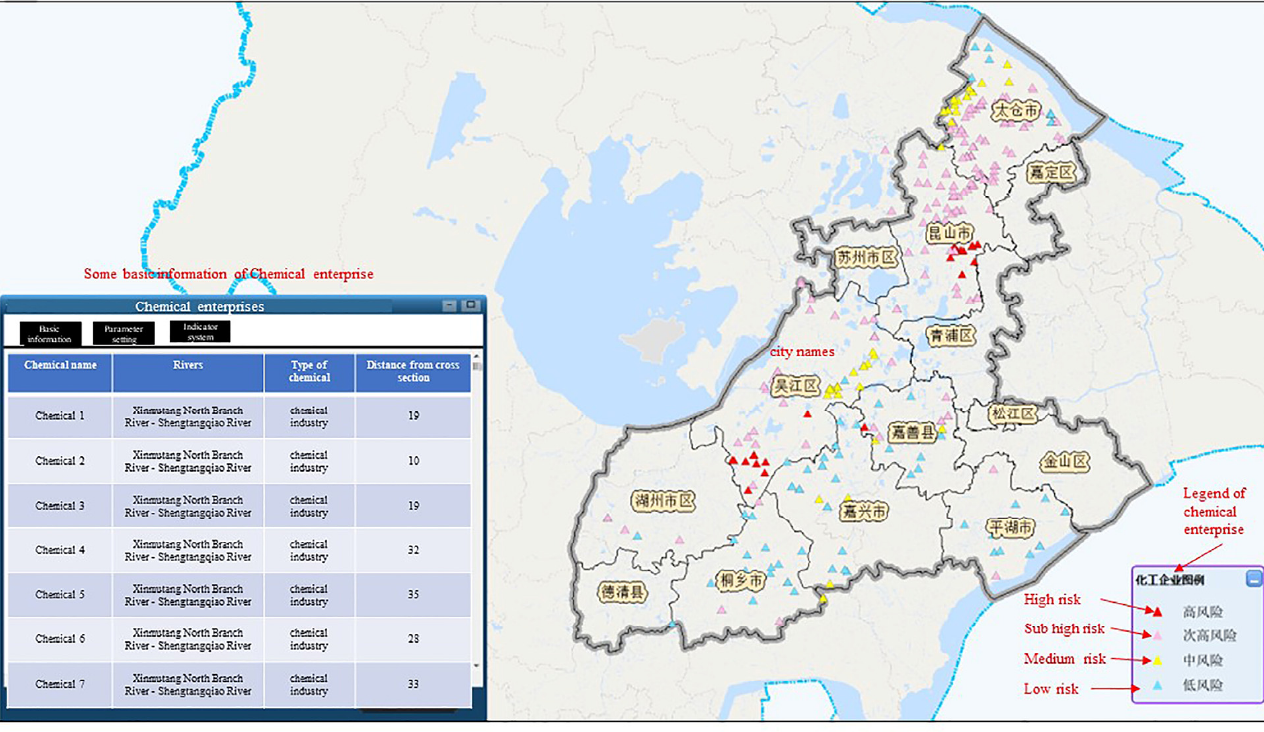
Figure 9. Risk assessment results for the sewage treatment plants.